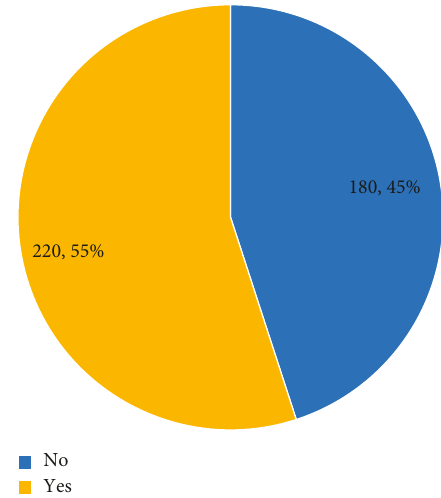
Figure 2: Awareness about the relationship between periodontal disease and pregnancy outcomes.